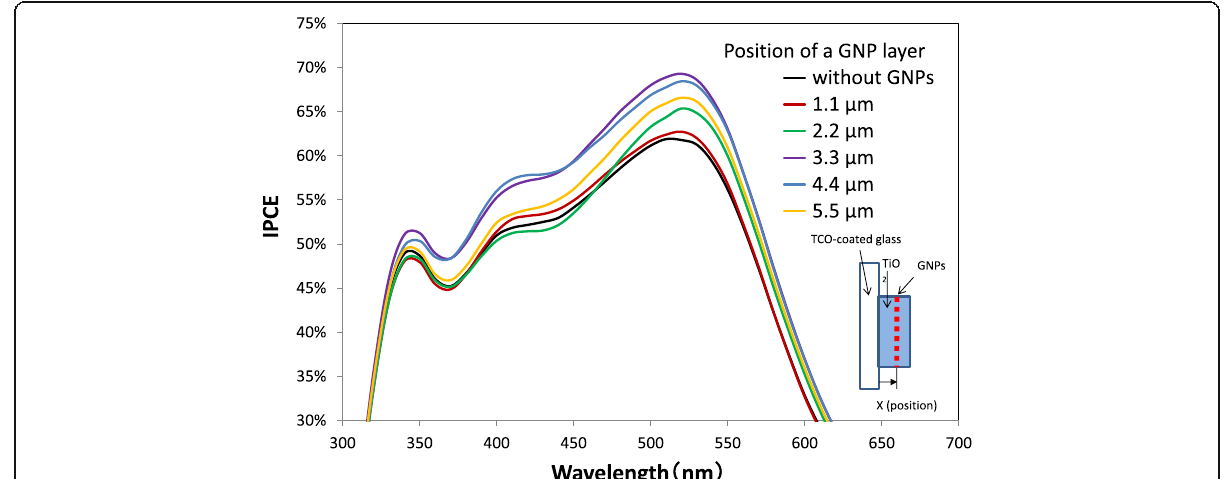
Fig. 9 IPCE spectra of the DSSCs with varying the position of a GNP layer. The density of GNPs is 2.7 μ g/cm 2